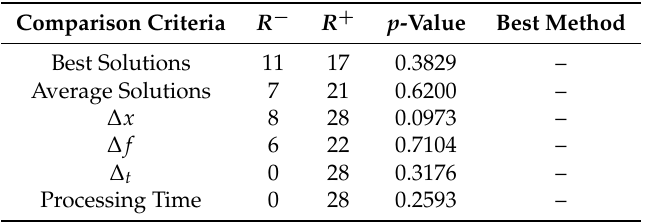
Table 12. Wilcoxon rank-sum test of DESSP and DSSSP results.